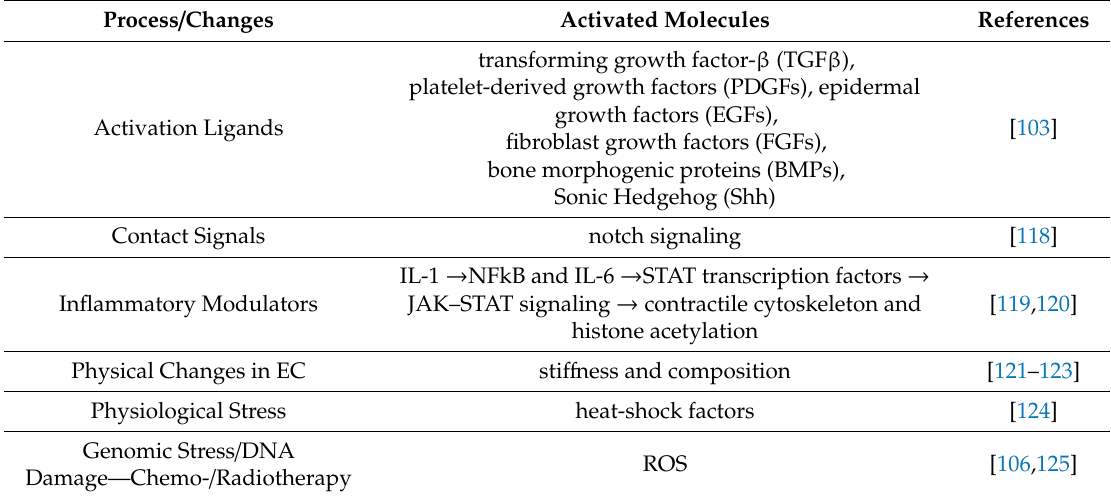
Table 1. Current mechanisms that can convert normal fibroblasts into cancer-associated fibroblast. Process /